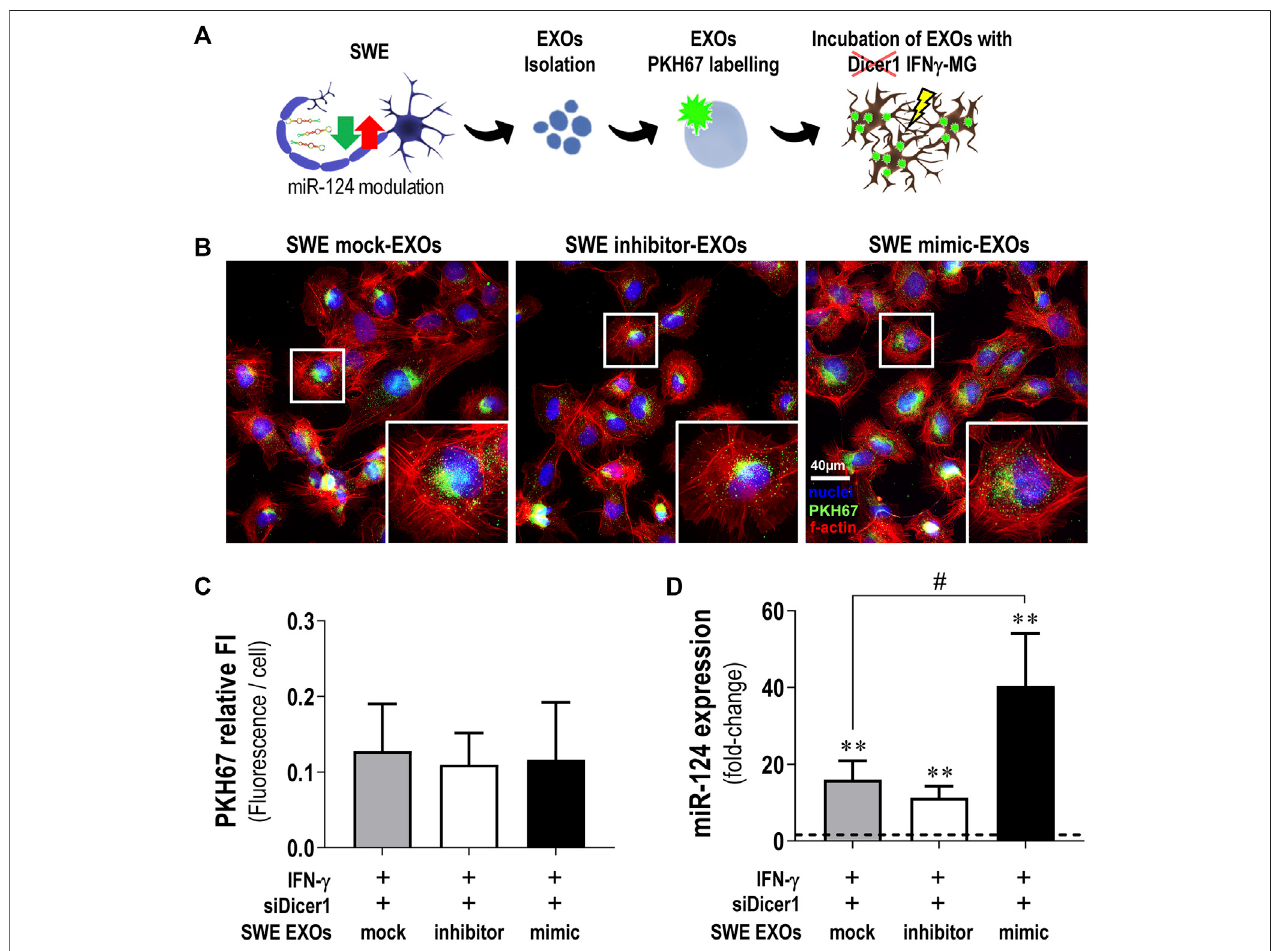
FIGURE 8 | SWE-derived EXOs ef fi ciently deliver miR-124 into Dicer1-silenced IFN γ -MG. After differentiation, SWE cells were transfected with mock or miR124 inhibitor and mimic, while CHME3 microglia were treated with IFN γ followed by Dicer-1 siRNAs, as described before. (A) Schematic representation of exosome (EXO) isolation from SWE cells expressing different miR-124 levels (mock, inhibitor, and mimic), labeling with the fl uorescent probe PKH767, and incubation with Dicer1- silenced IFN γ -MG. (B) Representative fl uorescence images of PKH67-labelled EXOs collected by Dicer1-silenced IFN γ -MG (green) and f-actin (red). Nuclei were stained withHoechst33258 dye (blue). (C) Quanti fi cation of PKH67 fl uorescence intensity (FI) per microglial cell. (D) Expression ofmiR-124 in Dicer1-silenced IFN γ -MG after incubation with SWE-derived EXOs (mock vs . inhibitor vs . mimic). Results are mean ± SD from at least three independent experiments. ** p < 0.01 vs . naïve MG (dashed line), one-way ANOVA with the Bonferroni post hoc test; # p < 0.01 vs . siDicer1 silenced IFN γ -MG cocultured with SWE mock exosomes, two-tailed Student ’ s t -test. SWE, human SH-SY5Y expressing the APP695 Swedish mutant protein; EXOs, exosomes; IFN γ -MG, IFN γ -stimulated CHME3 human microglia cells; siDicer1, siRNA-mediated Dicer-1